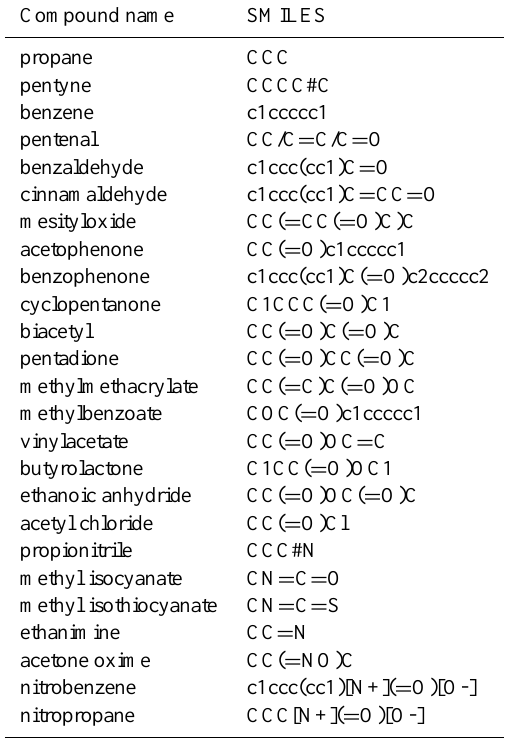
Table C2. List of compounds used to test the substructures 33–57 in Table